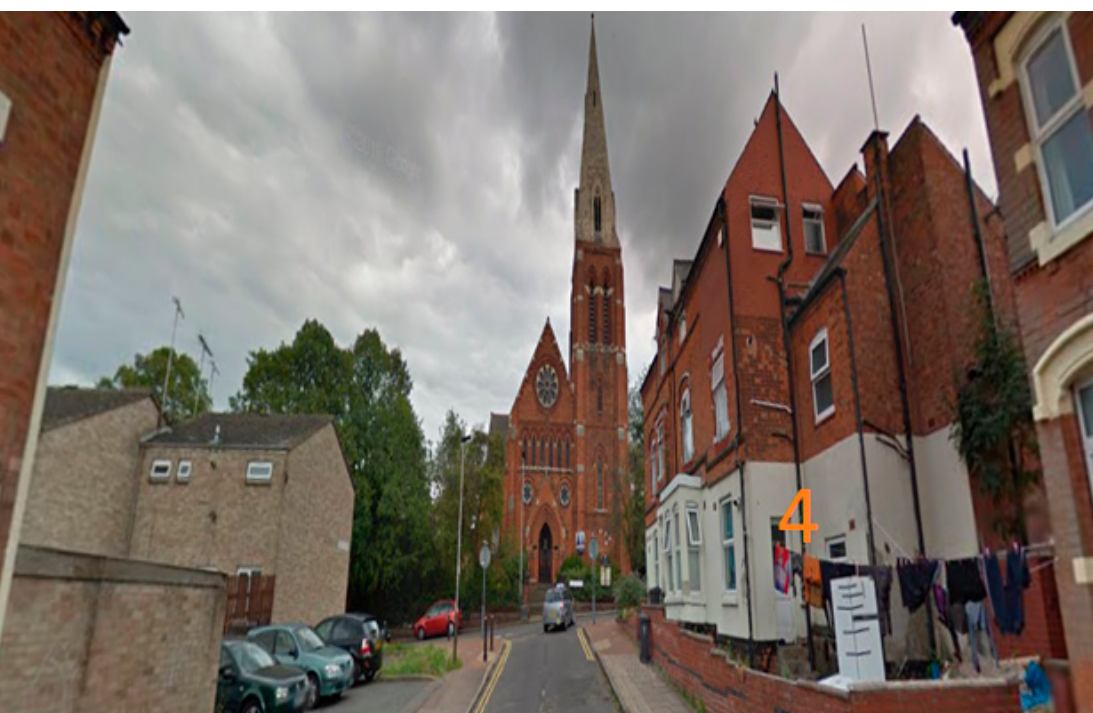
Figure A2. Location 2 (Map data ©2017 Google).